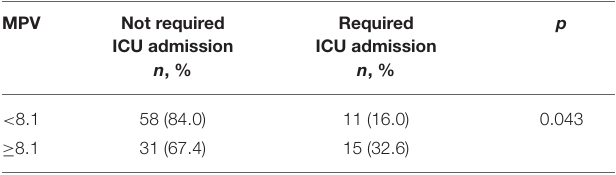
TABLE 5 | Comparison of intensive care unit admission rates according to mean platelet volume of 8.1 cut-off value when D-dimer ≥